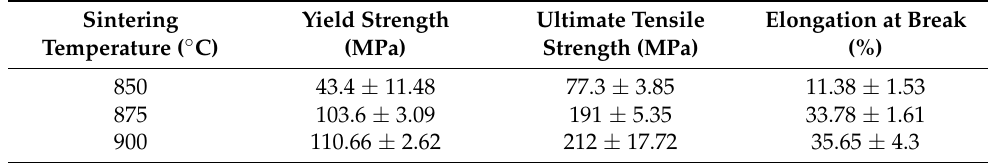
Table 3. Tensile properties of sintered samples.